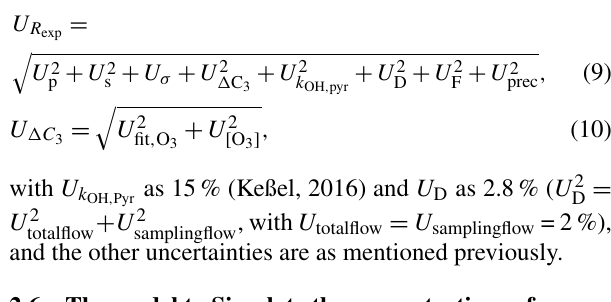
Figure 3. (a) Correction of C 3 ( (cid:49) C 3 , O pyr /